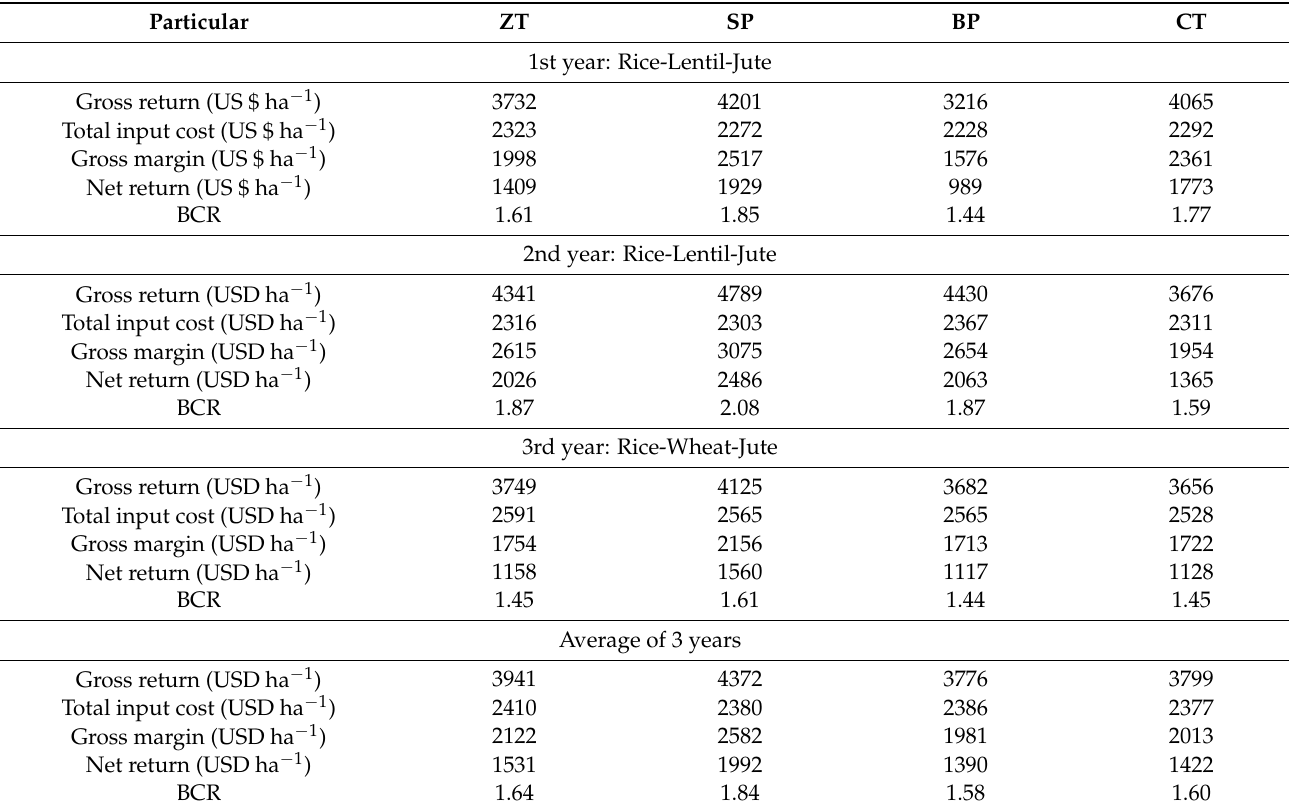
Table 6. Profitability of different tillage practices in the rice–lentil/wheat–jute cropping system. Particular ZT SP BP